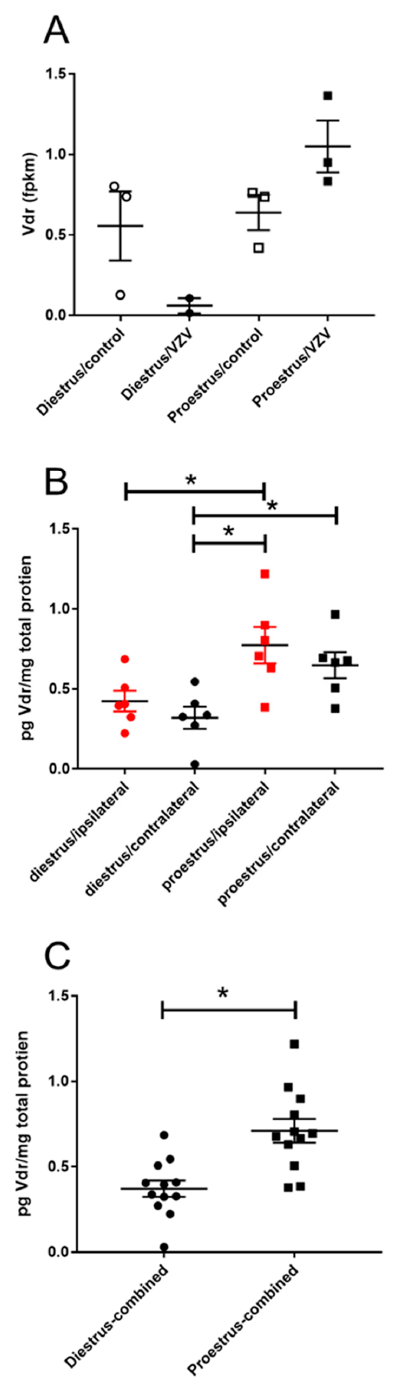
Figure 6. Expression of vitamin D receptor (Vdr) significantly increased in the amygdala region during proestrus. Rats were injected with varicella zoster virus in the left whisker pad to induce orofacial pain. Central amygdala brain tissue was collected from these female rats during the proestrus and diestrus phase of the estrous cycle. This tissue was analyzed for RNA (panel A ) and protein (panels B , C ). In panel ( B ) the right (contralateral to VZV injection) and left (ipsilateral to VZV injection) side of the brain was analyzed separately and in panel ( C ) the protein content from both sides of the brain were combined. Fragments Per Kilobase of transcript per Million mapped reads (fpkm). The asterisk indicates a significant di ff erence between groups p <